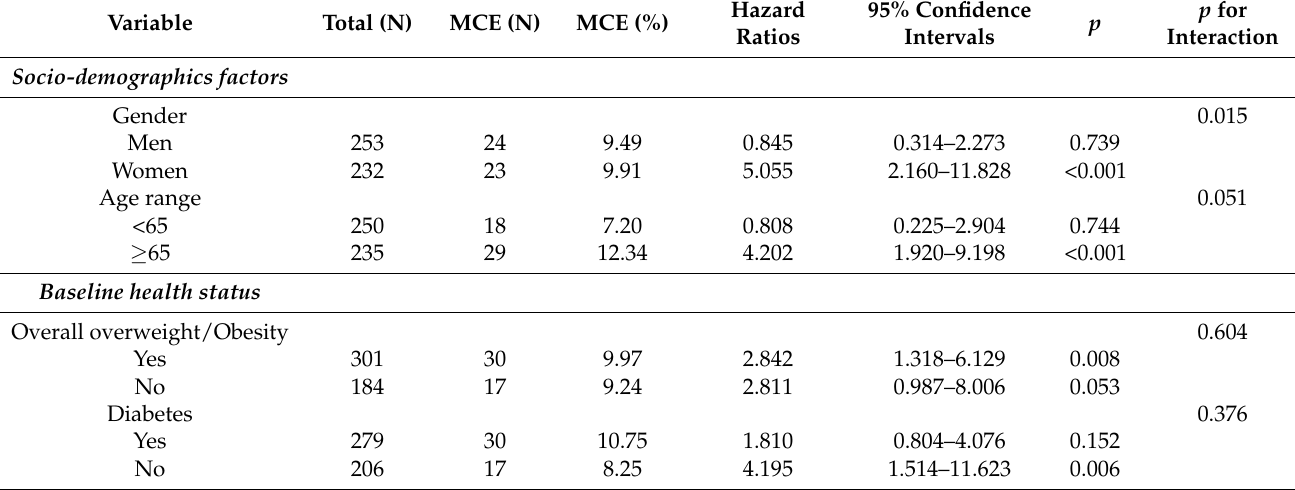
Table 3. Interactions of subgroup factors on the association between prognostic nutritional index levels and major cardiovascular events